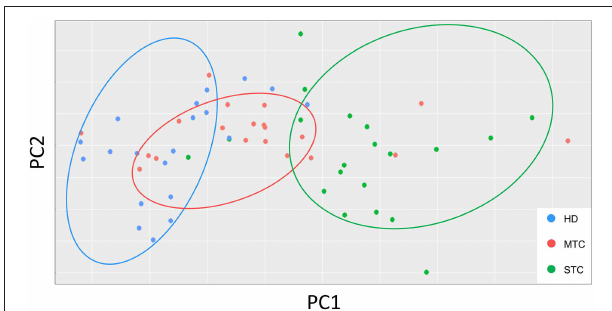
FIGURE 2 | PCA graphs show the distribution of each patient according to their intragroup similarity and between groups. PCA graphs consist of a multivariate type analysis based on the Z value and included the all soluble molecule variables of the patients before treatment. The coefficient correlation factor is considered significant when p <